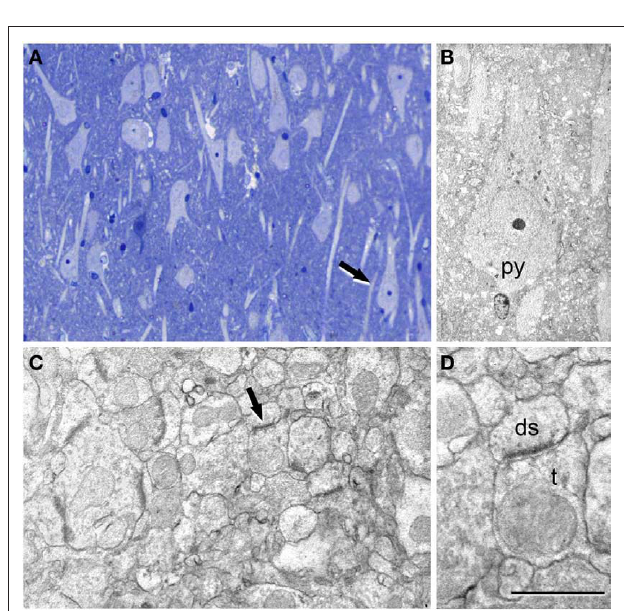
FigurE 4 | Correlative light and electron microscopy of the subiculum region from a sclerotic hippocampus. (A) Photomicrograph of a 2-μm-thick semithin plastic section stained with 1% toluidine blue to show the numerous pyramidal cells. (B) Low-power electron micrograph taken after sectioning the semithin section shown in A, and illustrating the same pyramidal neuron (py) indicated with an arrow in (A) . (C) Higher magnification of the adjacent neuropil shown in (B) to illustrate the numerous synapses. (D) Higher magnification of the asymmetric synapse (indicated with an arrow in C ); ds, dendritic spine; t, axon terminal. Scale bar [in (D) ]: 120 μm in (A) , 58 μm in (B) , 1 μm in (C) , and 0.5 μm in (D)